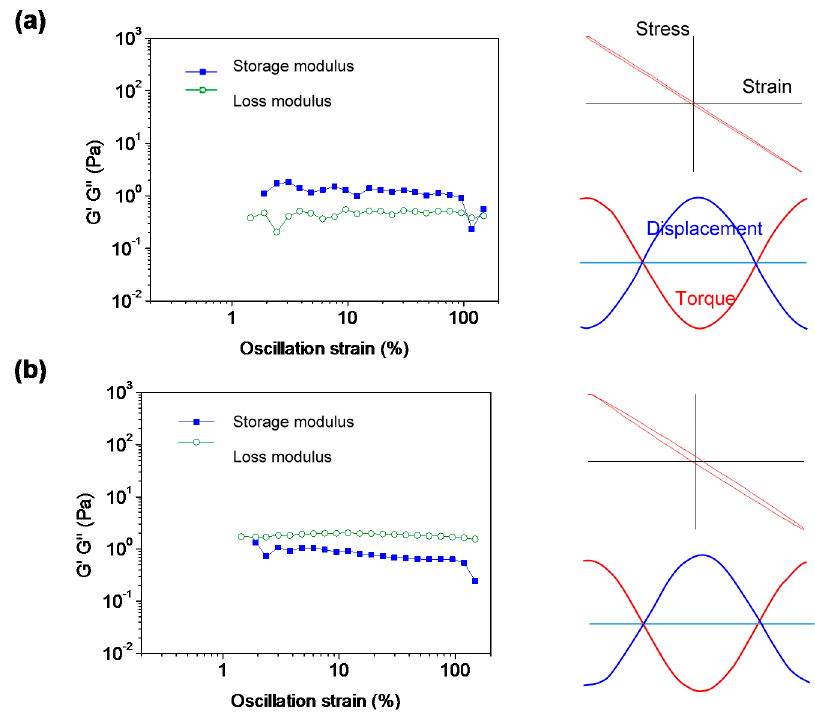
Figure 5. Oscillatory amplitude sweep of 15 wt % polymers at 25 °C; ( a ) F127; and ( b ) F127-POSS, and corresponding sinusoidal waveforms. The tests were performed at a strain percent range of 0.5%–150%, with a fixed frequency at 1 Hz.